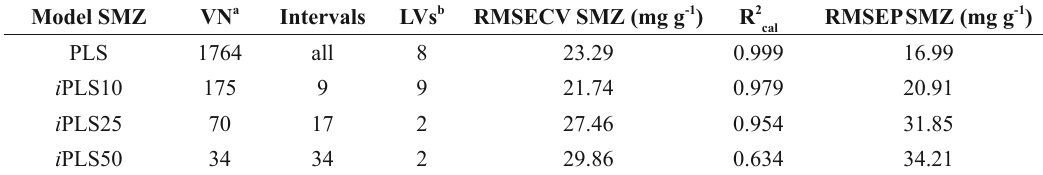
Statistical results to i PLS calibration models and full-spectrum PLS model for the